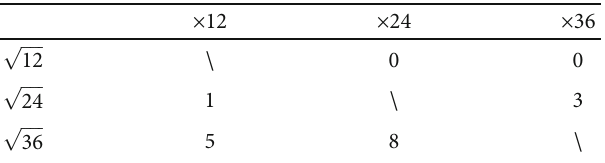
— Figure 7: Inferred outdoor mechanical property degradation of